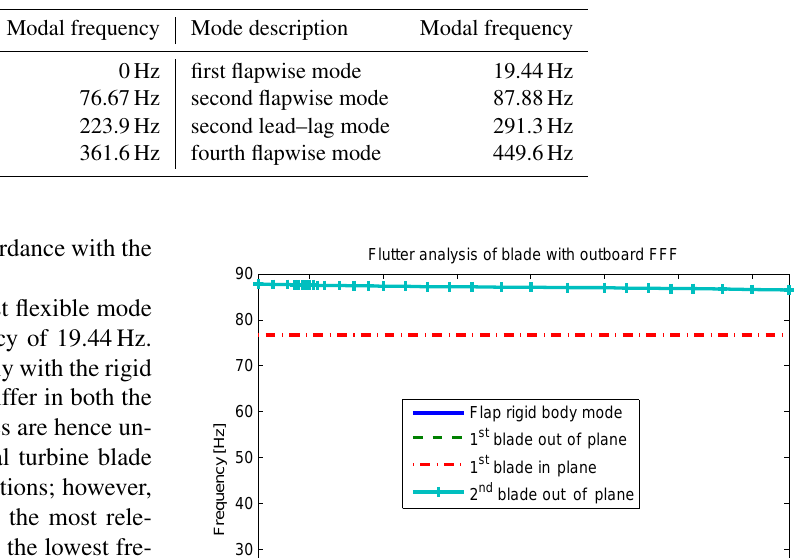
Table 1. Structural modes of the blade at zero total air speed.